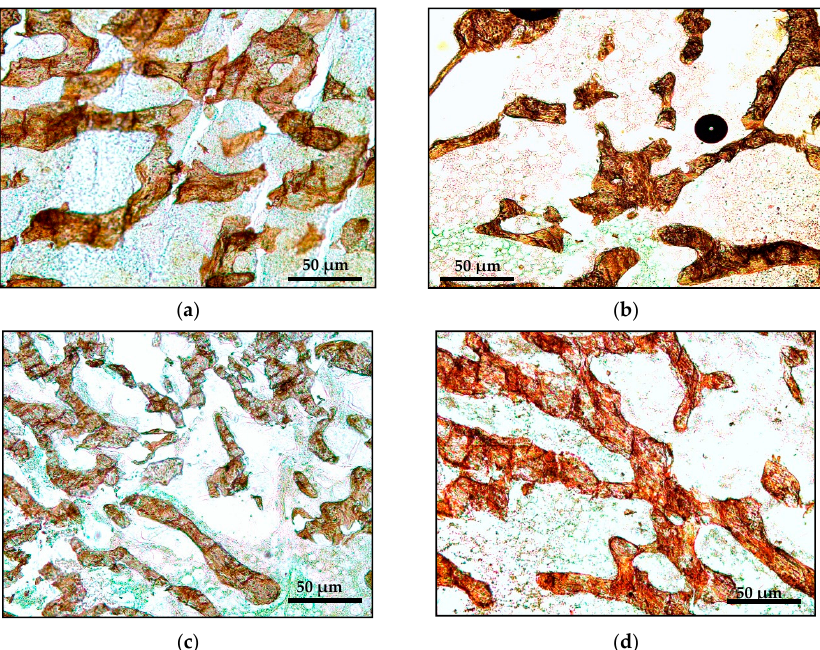
Figure 1. Photomicrograph of decalcified trabecular bones for structural histomorphometry parameters